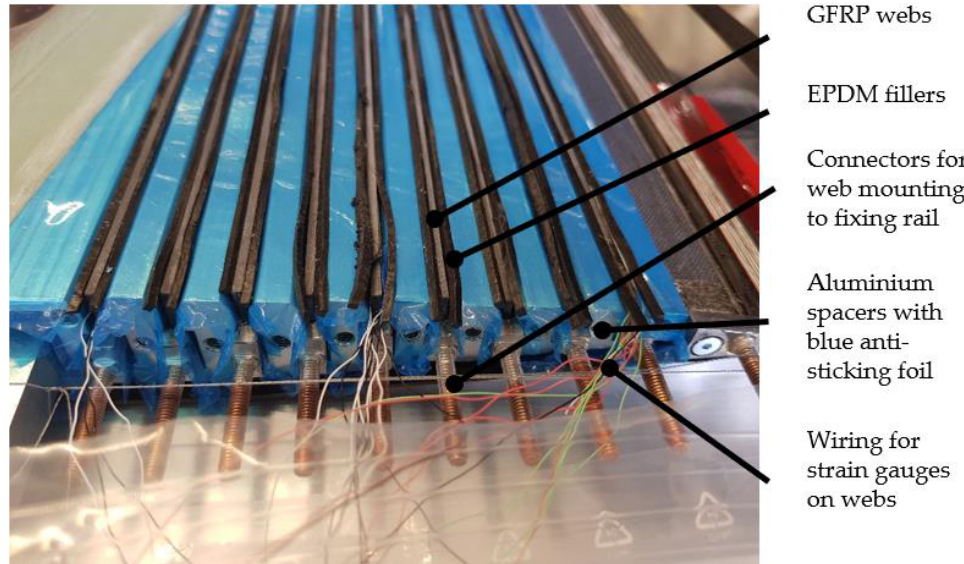
Figure 5. Preparation for the autoclave cycle: mould recesses are filled with EPDM strips; the upper EPDM skin is not yet applied.